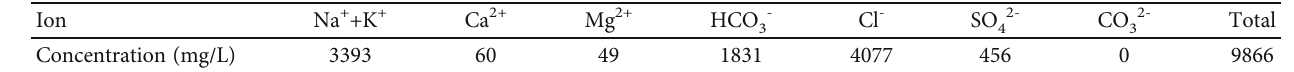
Table 1: Ionic composition of brine water.